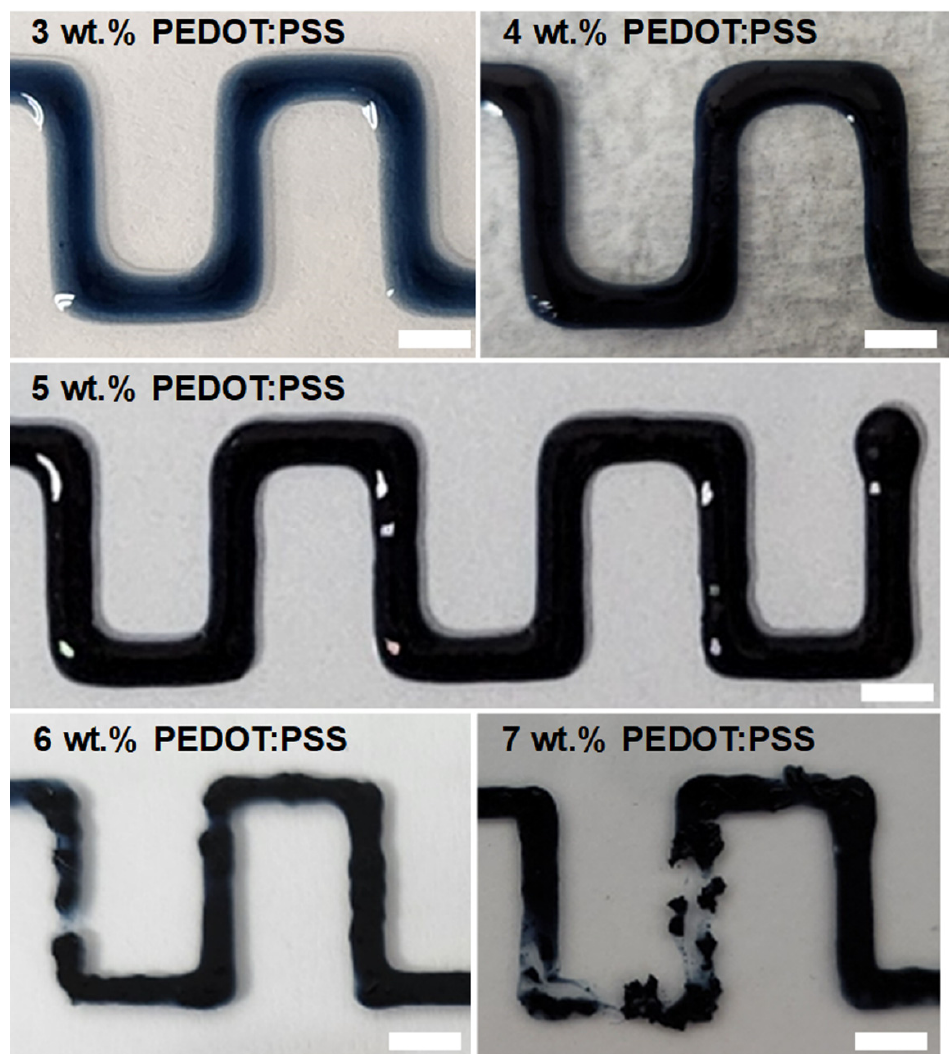
Figure 2. Photo images of the direct ink written-PEDOT:PSS electrodes on the glass substrate according to the PEDOT:PSS ink concentrations. Scale bars: 5 mm.